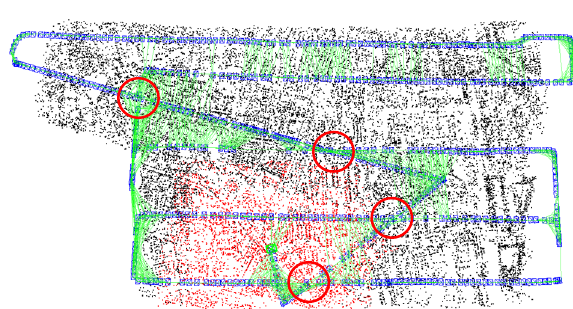
Figure 1. Arbitrary UAV flight for real-time photogrammetry. The red circles denote the locations where image retrieval should work to find the loop